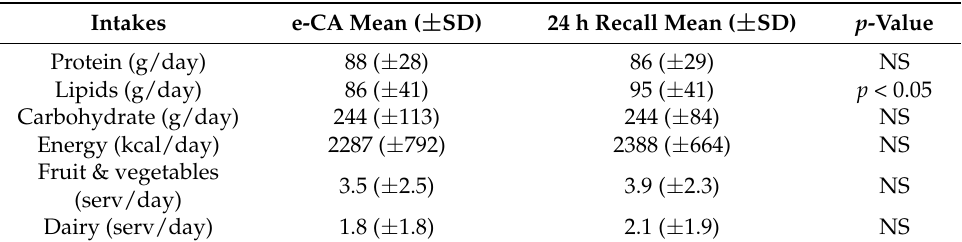
Table 1. Paired comparisons (Wilcoxon signed-rank tests) of mean intake of nutrients, energy, and food groups measured with the e-CA app and two 24 h